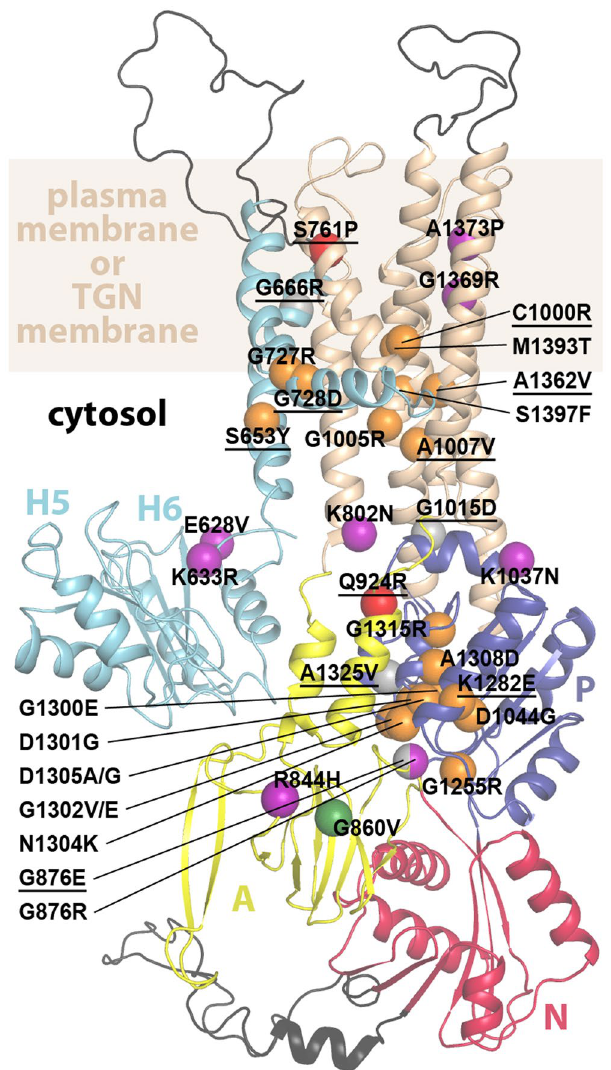
Figure 11. Distribution and effect of ATP7A disease-causing missense mutations. The mutations, presented in this study, are plotted as spheres in a previously established homology model of ATP7A 7 , based on the crystal structure of the homologous protein LpCopA from Legionella pneumophila 3 . The various domains of ATP7A are colored as in Fig. 1. However, metal-binding domains 1 to 4 (H1–H4) are not depicted in the figure, as their structural localization is unknown, and regions with major insertions relative to LpCopA are shown in black. The approximate position of the (TGN- or plasma-) membrane is shown in wheat. The color of spheres represent the mutational effect on ATP7A localization: Copper dependent trafficking of the protein (blue); retention in post-Golgi compartments (grey); retention in the trans-Golgi network (orange); not certain (green); no detectable protein (purple). Underlined missense mutations have been reported to confer a non- classical phenotype. A1325V leads to classical MD in some patients (see Fig.